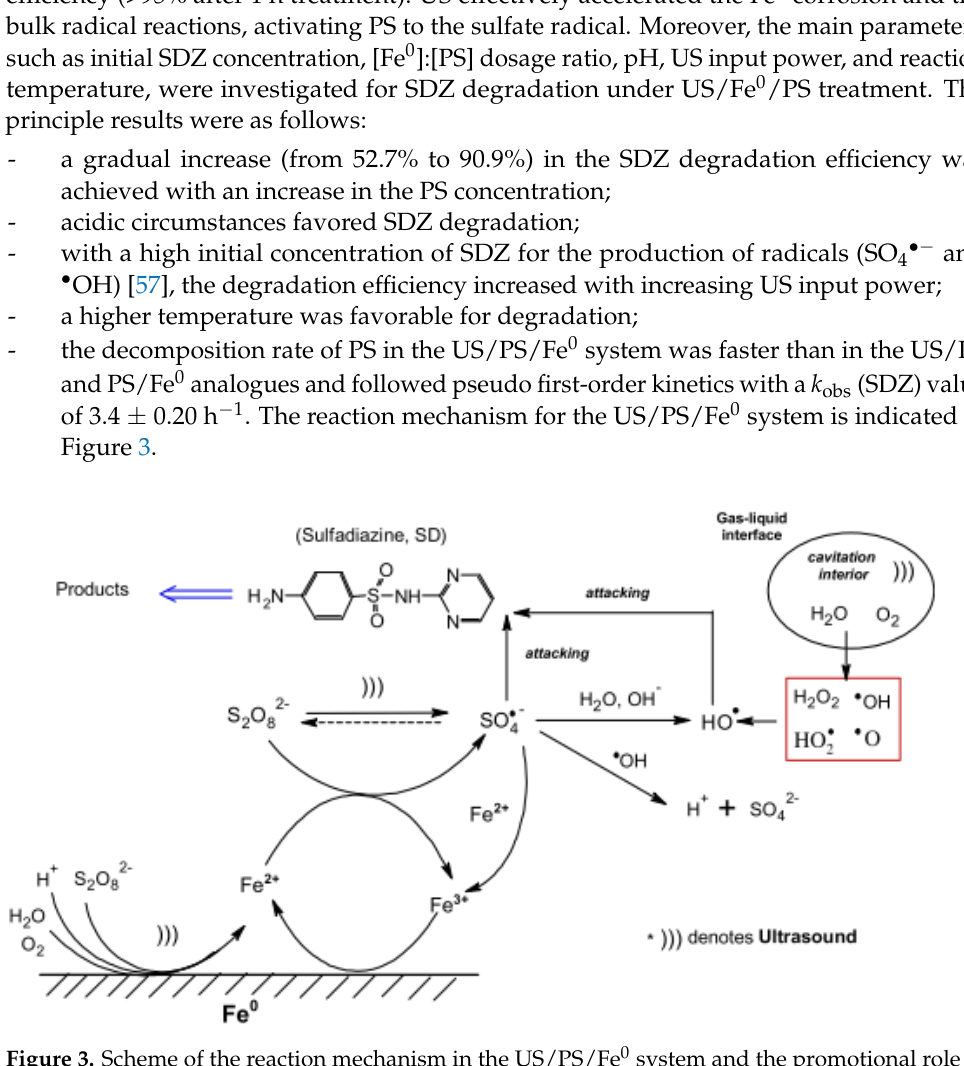
Figure 3. Scheme of the reaction mechanism in the US/PS/Fe 0 system and the promotional role of US. Reprinted with permission from [41].